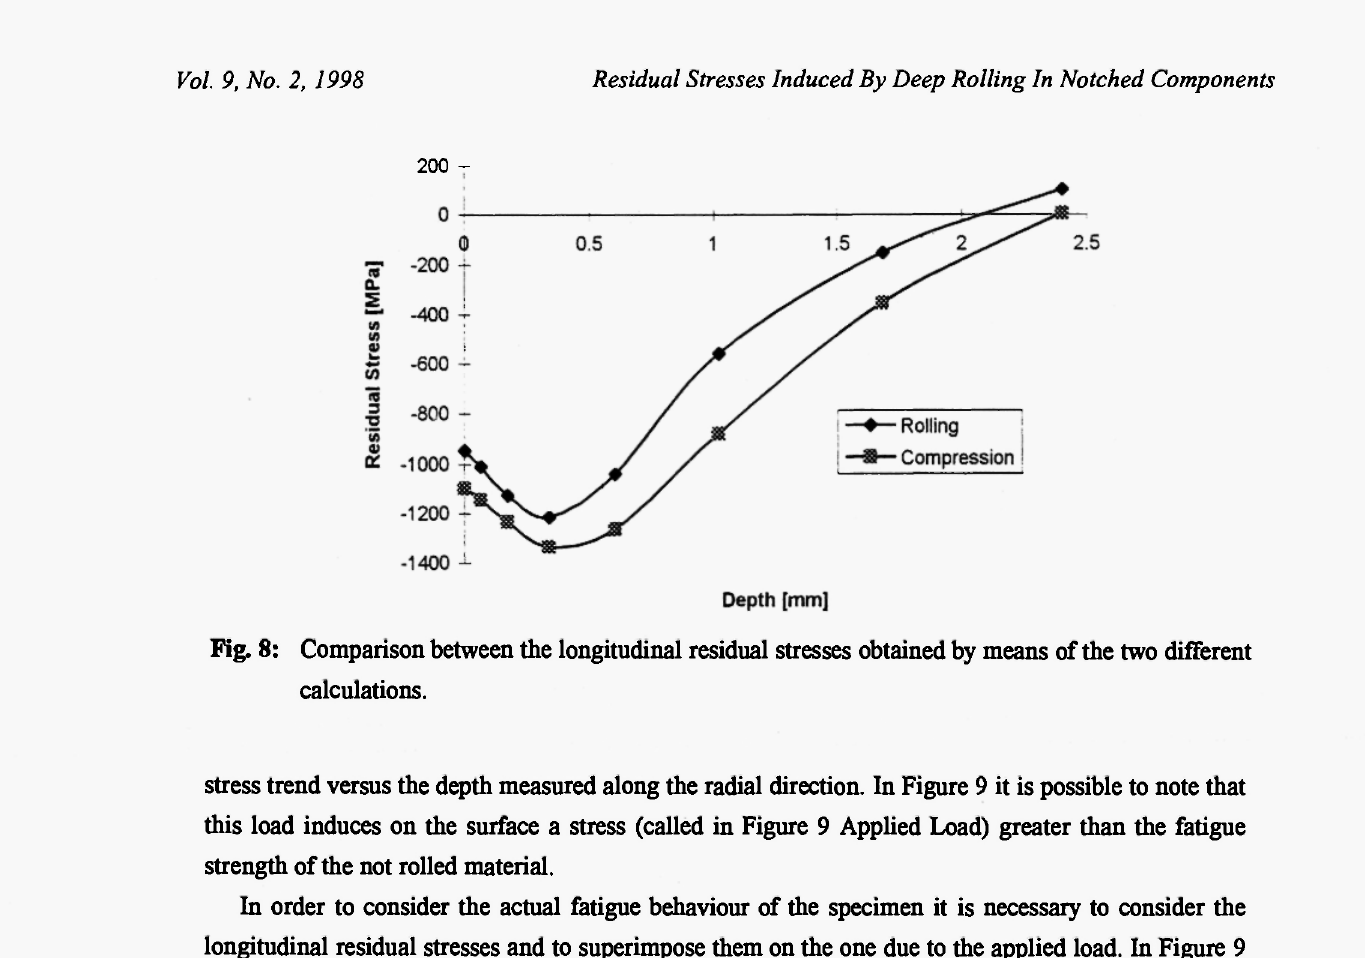
Fig. 8: Comparison between the longitudinal residual stresses obtained by means of the two different calculations.